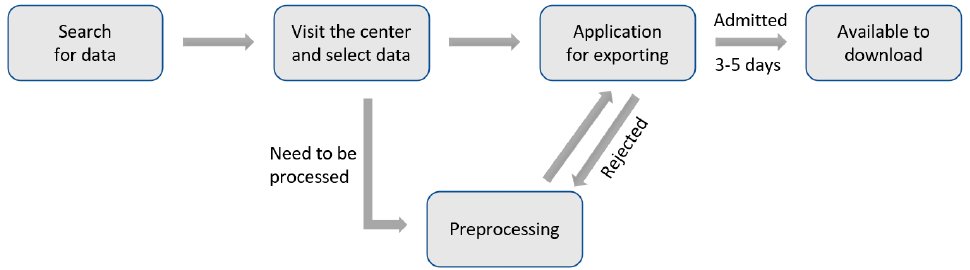
Figure 6. Data collection procedure of the Seoul Bigdata Campus.